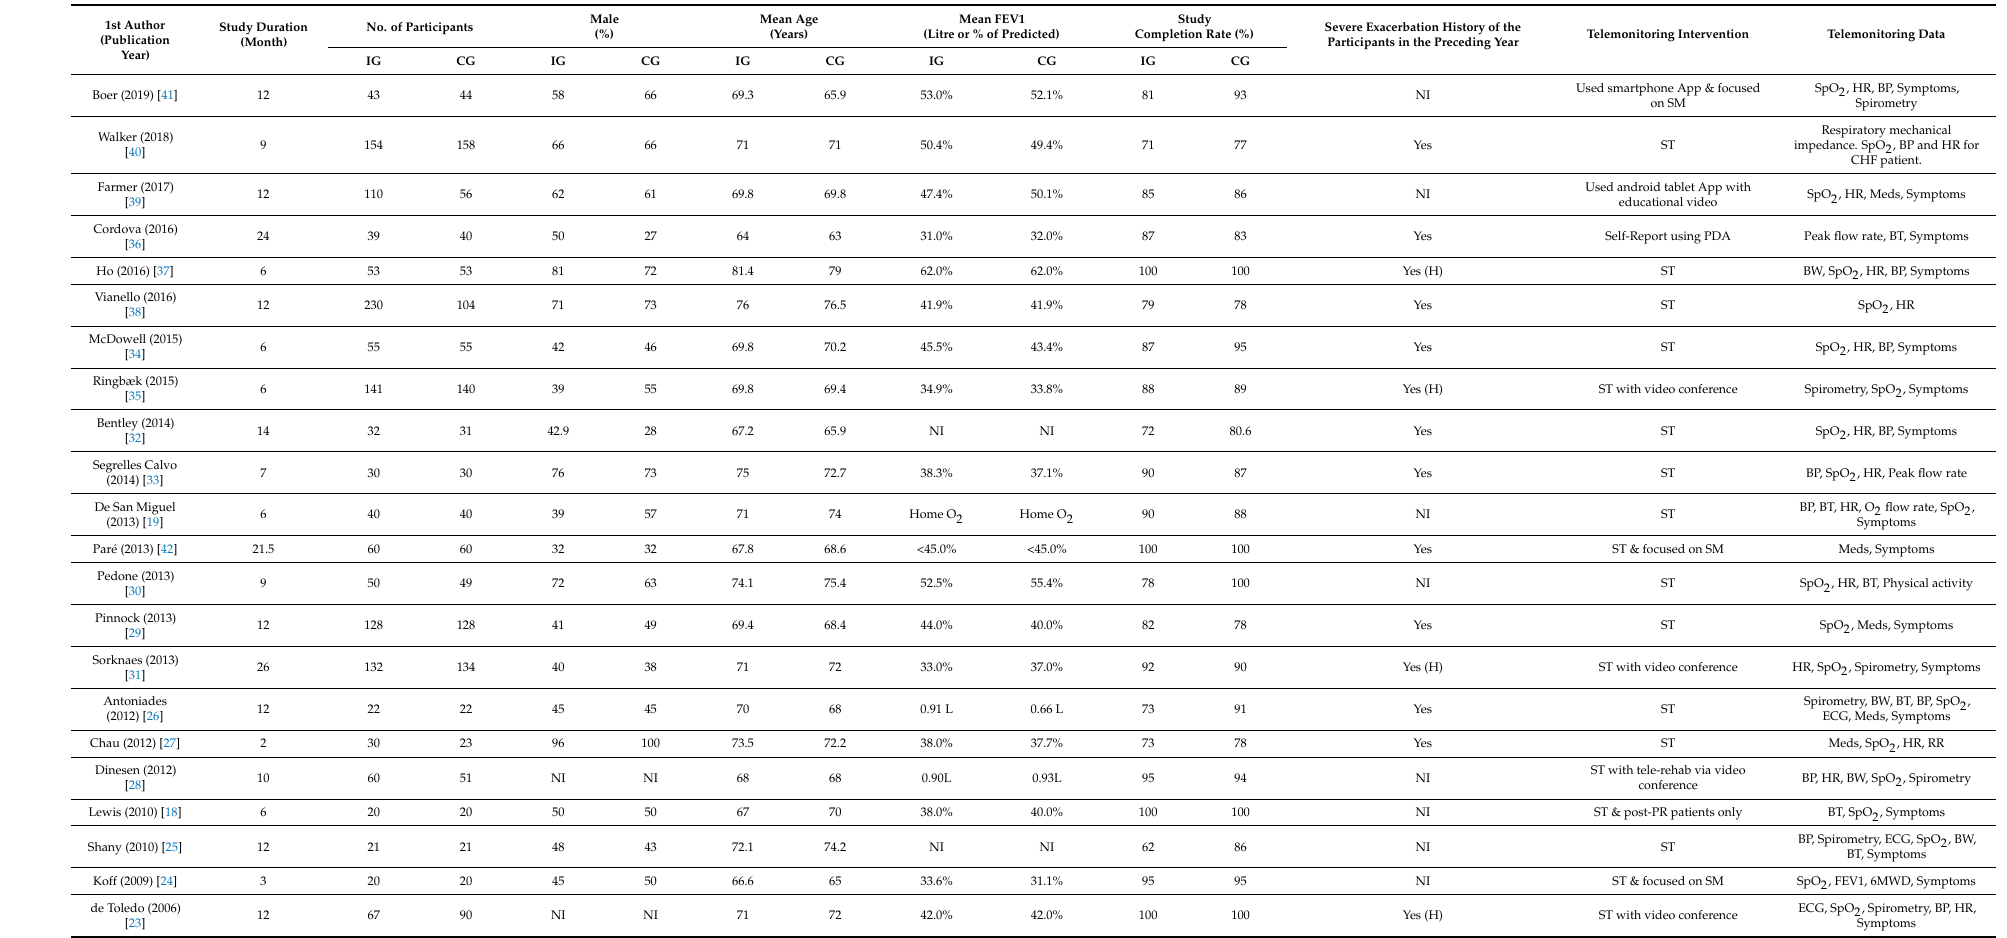
Table 1. Characteristics of the 22 included